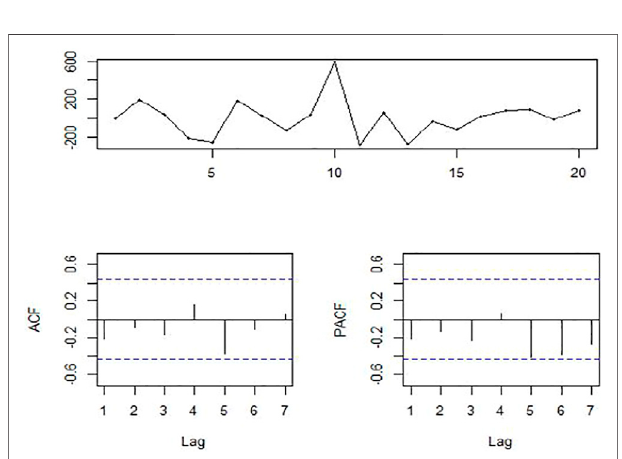
FIGURE 4 | Processed autocorrelation and partial autocorrelation plots of the residuals of the ARIMA (4, 1, 0).